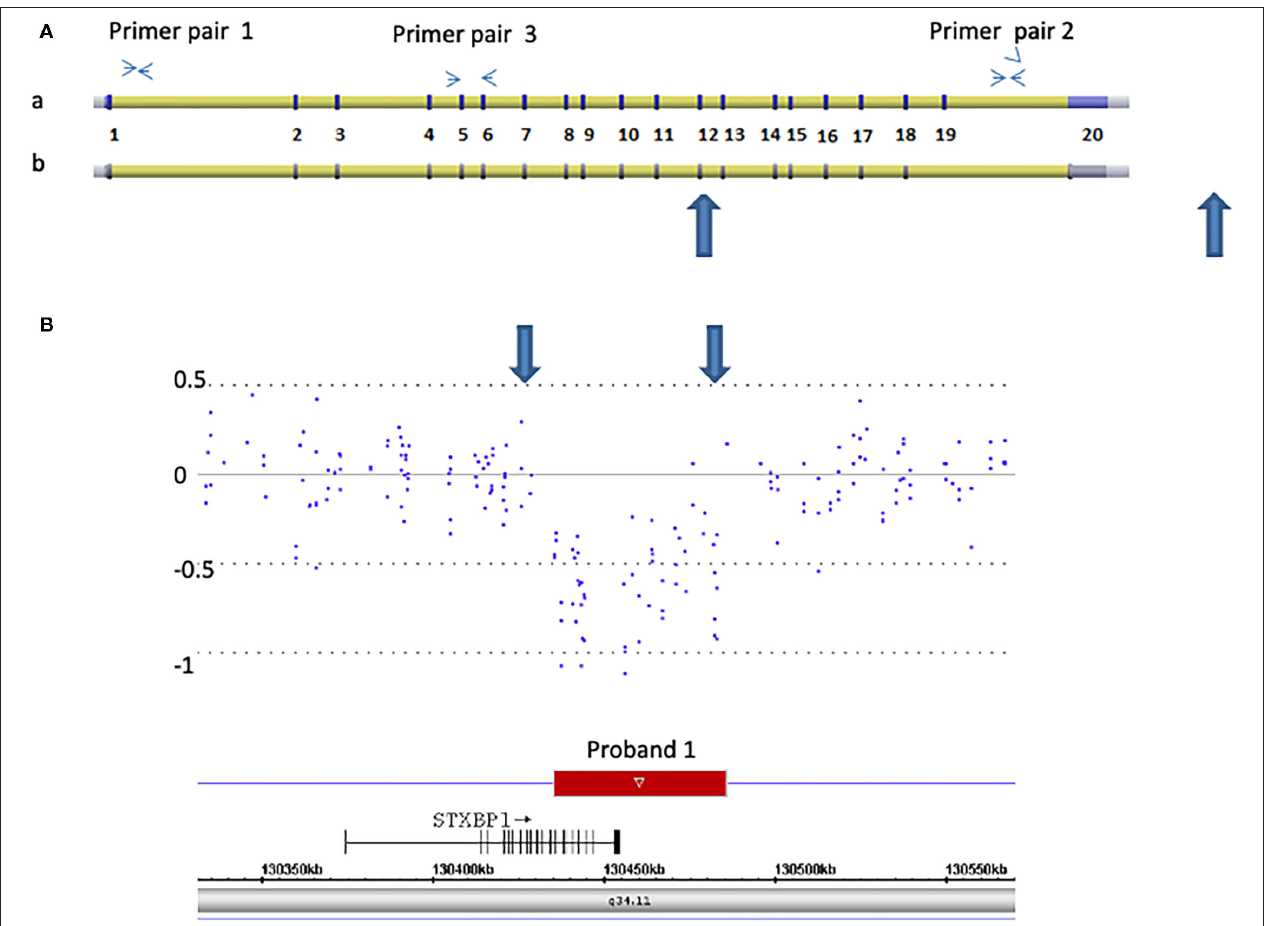
FIGURE 1 | Detection of a 50kb deletion of STXBP1 , exons 13 through 20 and 3 ′ downstream genomic region in proband 1. (A) Schematic representation of two isoforms of STXBP1 (a: NM_003165. b: NM_001032221) (not scaled). The exons (numbered 1–20) and introns are shown. Primer pairs 1 and 2 are located at introns 1 and 19, respectively. They were used for Q-PCR analysis. Primer pair 3 is located at exons 5 and 6 and was used for RT-Q-PCR analysis. (B) Microarray scan of ∼ 250kb region encompassing the STXBP1 region. CytoScan HD array probes over the region are represented as dots. The numbers on the Y-axis represent Log2 values. The rectangle represents the region deleted. The STXBP1 gene relative to the deletion (small arrow indicates the orientation from 5 ′ to 3 ′ of the gene), genomic location [hg19], and chromosome 9 band is indicated. Large blue arrows demarcate the region deleted in both (A,B) .